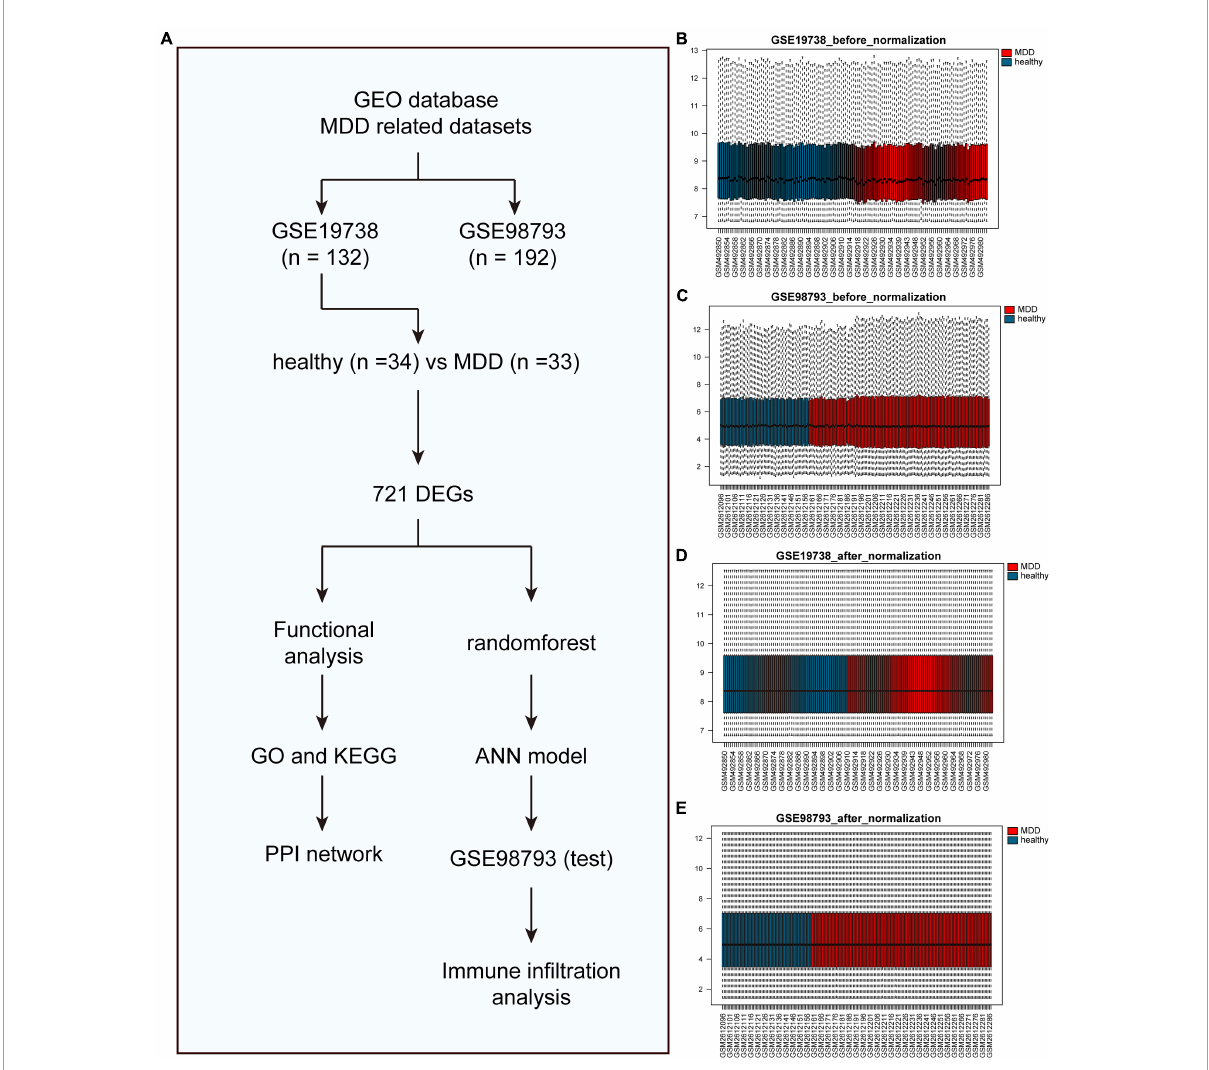
FIGURE1 Before and after box diagram of standardization of GSE19738 and GSE98793 datasets. (A) The flow chart of this study. (B) Box diagram of the GSE19738 dataset before correction; (C) Box diagram of the GSE98793 dataset before correction; (D) Box diagram of the GSE19738 dataset after correction; and (E) Box diagram of the GSE98793 dataset after correction; Red represents the MDD samples, and blue represents the normal